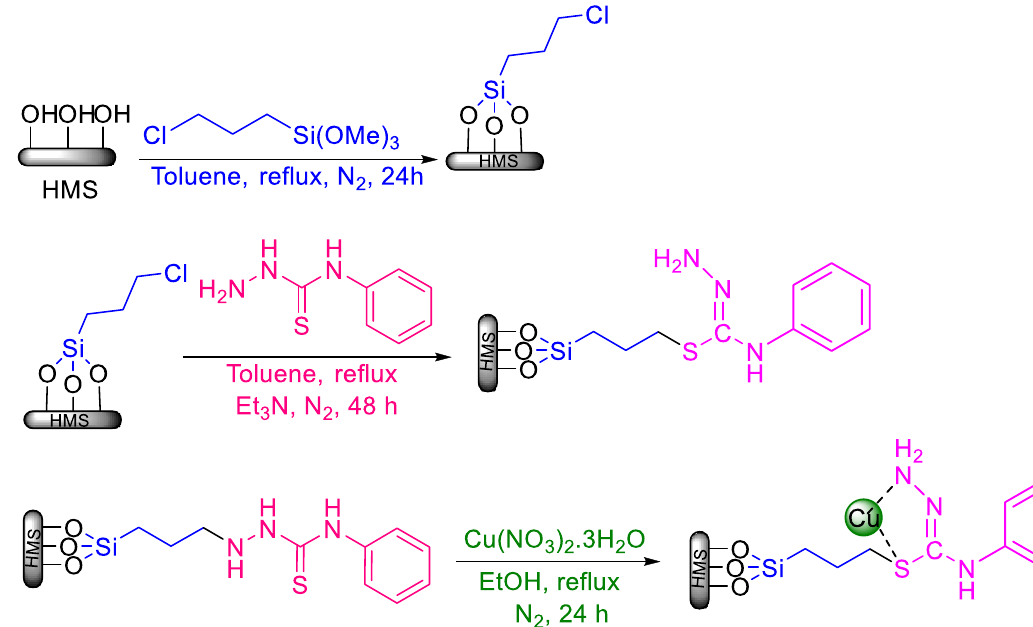
Figure 2. General procedure for synthesis of HMS/Pr-PTSC-Cu.